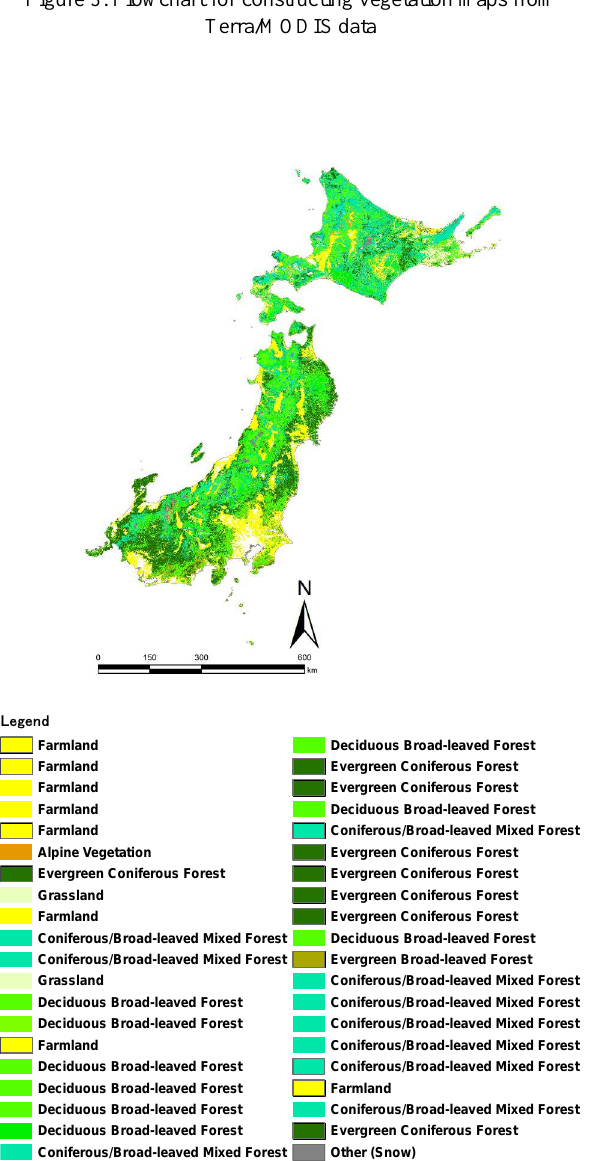
Figure 4. 40 vegetated categories by ISODATA method classification of Terra/MODIS data